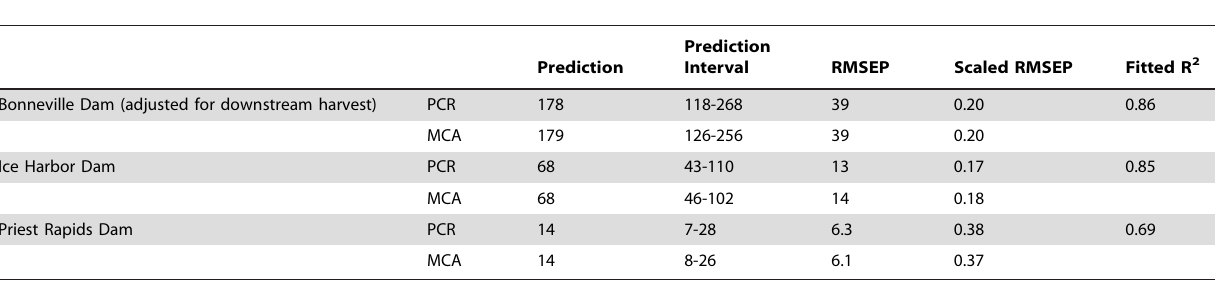
Table 3. Model performance and predictions (in thousands of fish) for fish returning in